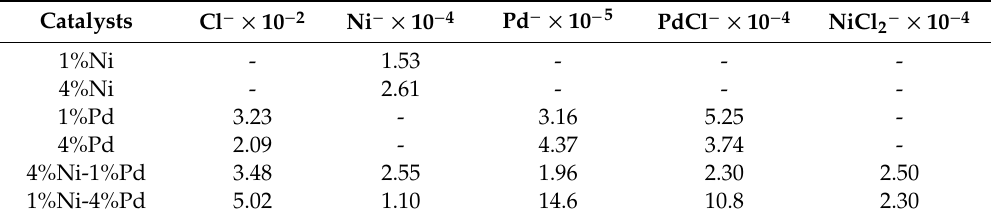
Table 1. Normalized intensity of selected ions identified on the surface of the catalysts.